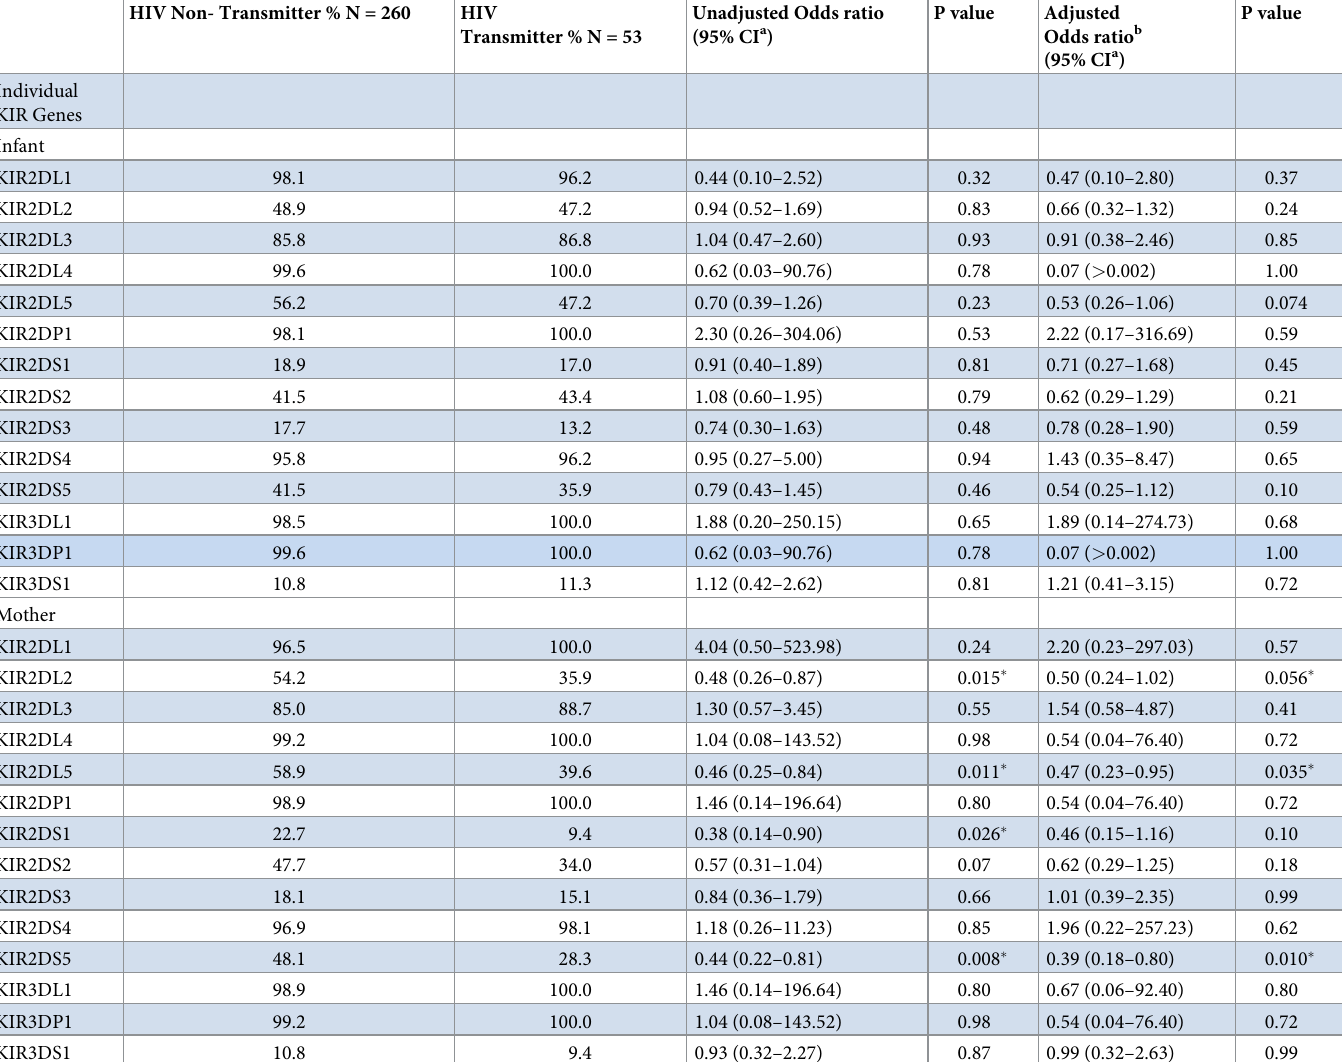
Table 2. Relationship of individual KIR genes with perinatal transmission of HIV-1. HIV Non- Transmitter % N =